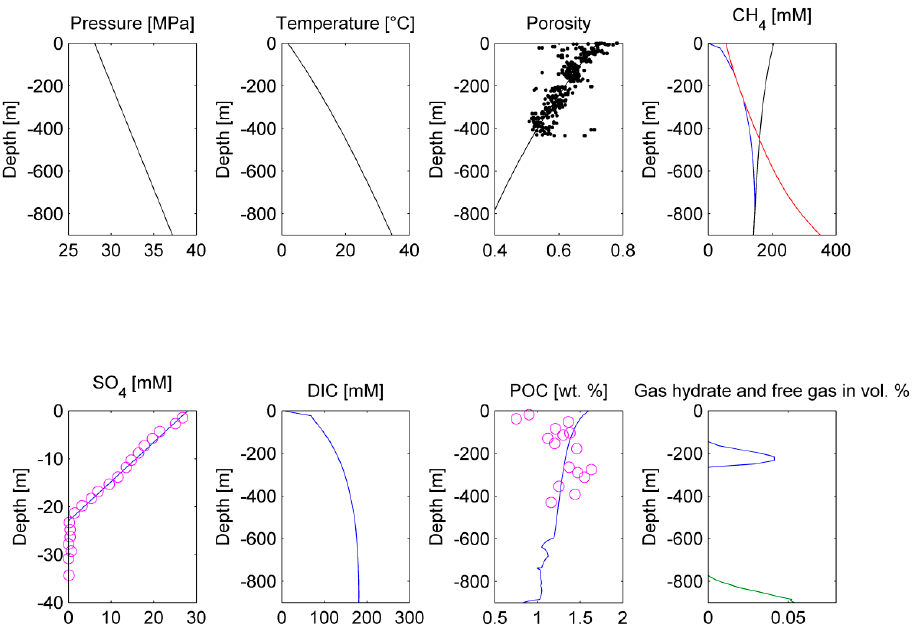
Figure 6. Modeling results of the Scenario 2c. Upper panel, from the left: Pressure, temperature, porosity, and dissolved CH 4 concentration plots. Porosity measurements [20] are depicted as black dots, the modeling solution is represented by the black line. On the CH 4 concentration plot, red line depicts the phase boundary between gas hydrate and dissolved methane, black line represents the phase boundary between free gas and dissolved methane, blue line states dissolved methane concentration. Gas hydrate and/or free gas formation occurs wherever dissolved methane concentration exceeds one of the solubility curves. Lower panel, from the left: SO 4 , DIC, POC, and gas hydrate/free gas concentration plots (in blue and green, respectively). On the SO 4 and POC concentration plot, measured values are presented as pink circles [20], whereas model predictions are shown as the blue lines.